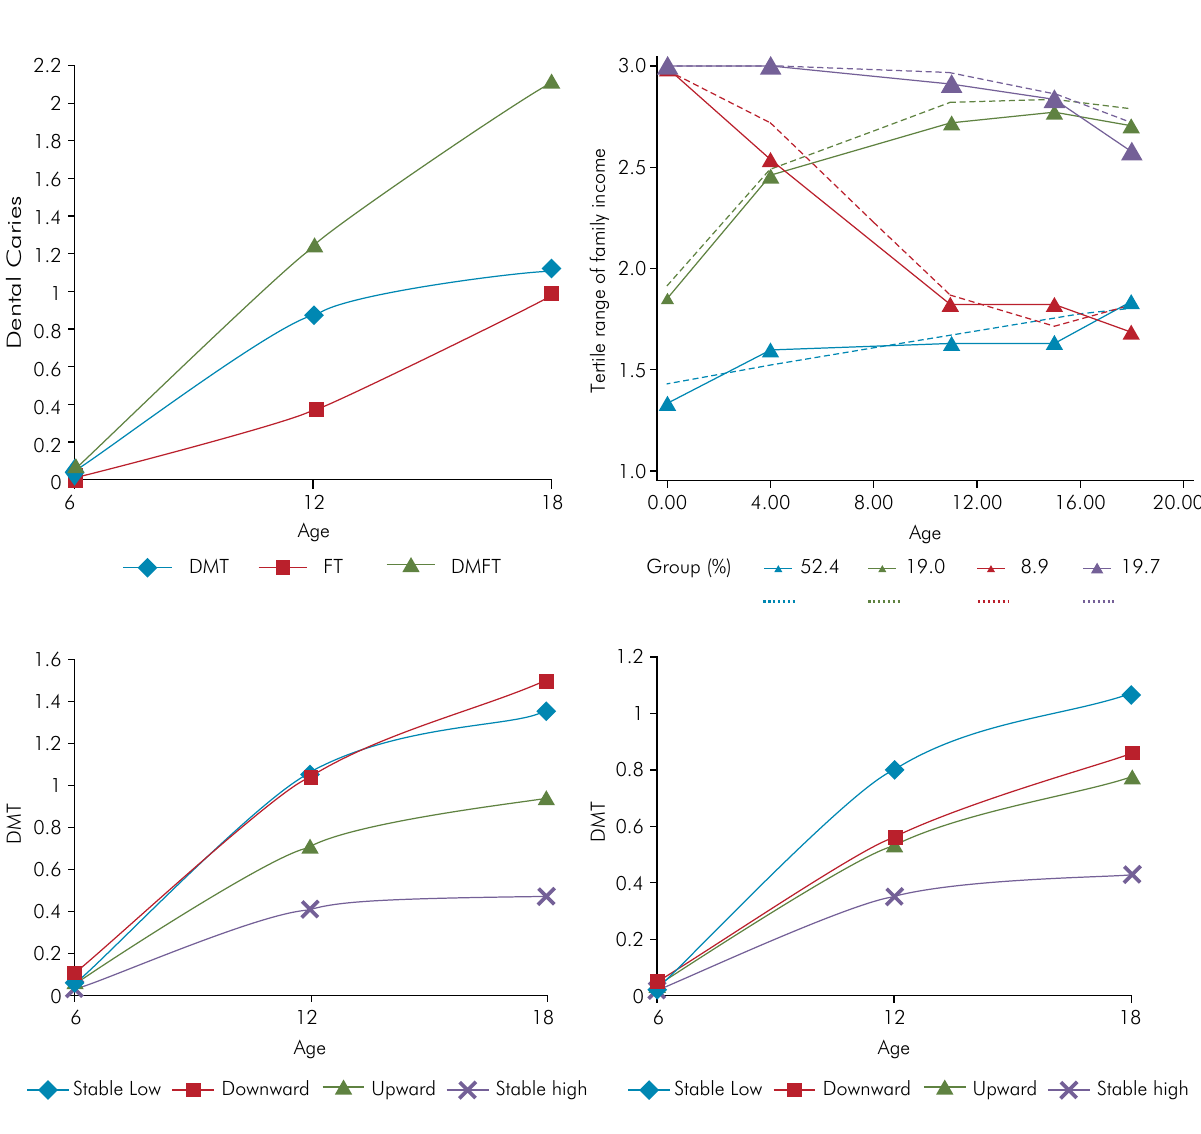
Figure 1. (a) Means or DMT/FT/DMFT. (b) Family income trajectories. (c) Mean DMT calculated from data vs income trajectories. (d) Estimated DMT count with the separate crude model vs income